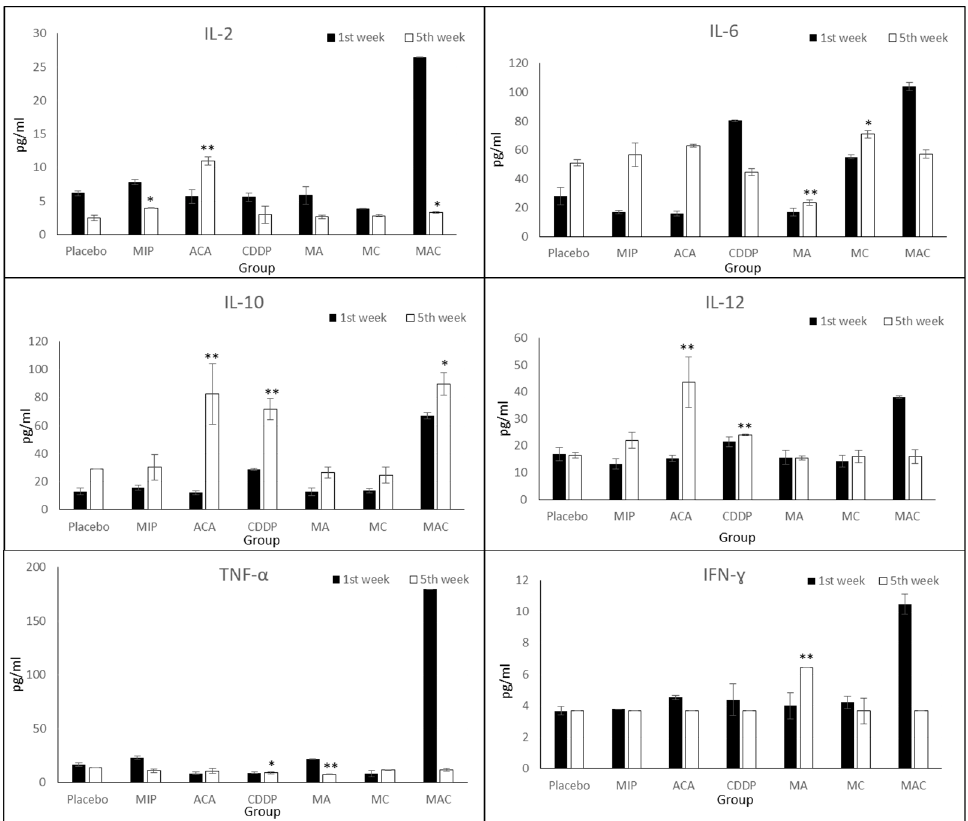
Figure 6. Expression levels of cytokines upon treatment using blood serum on the first and fifth week of the treatment. Treatment groups include placebo, 1 ′ -S-1 ′ -acetoxychavicol acetate (ACA), Mycobacterium indicus pranii (MIP), cisplatin (CDDP), ACA/MIP (MA), CDDP/MIP (MC), and ACA/MIP/CDDP (MAC). Statistically significant changes between the placebo and treatment groups on the fifth week are indicated as * for p < 0.05 and ** for p < 0.01.